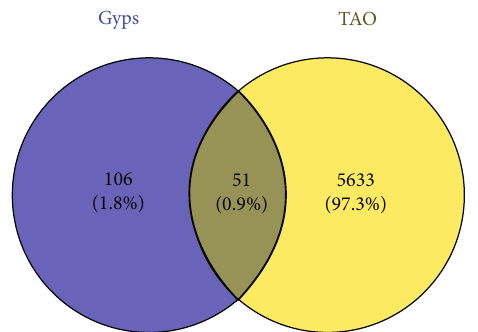
Figure 2: Venn diagram obtained the common target of thyroid- associated ophthalmopathy and gypenoside saponins by